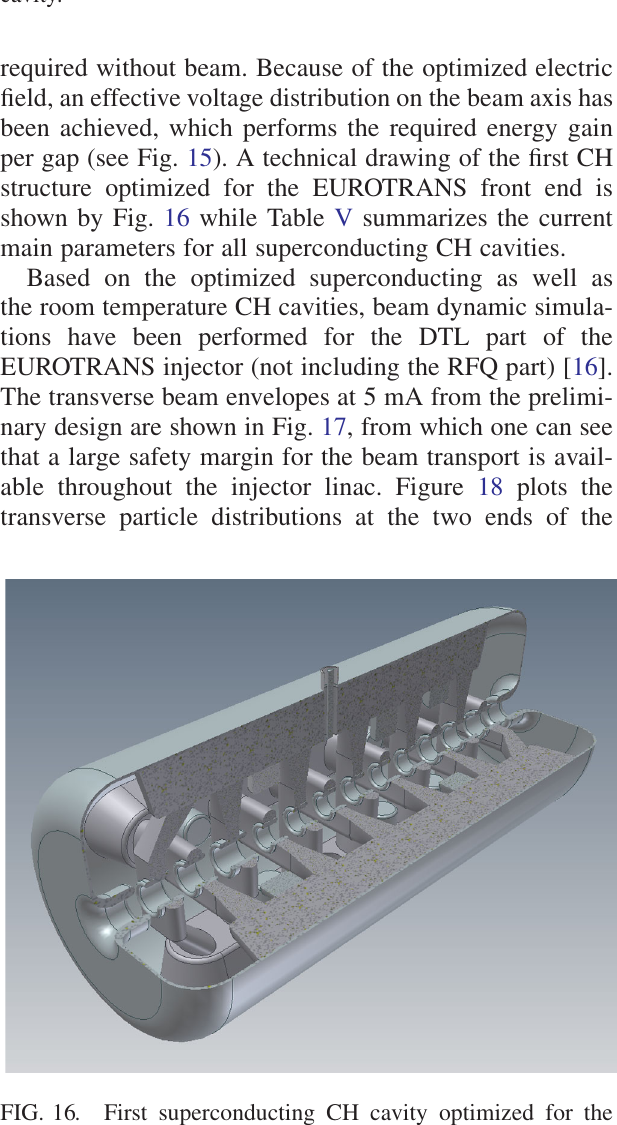
FIG. 16. First superconducting CH cavity optimized for the EUROTRANS front